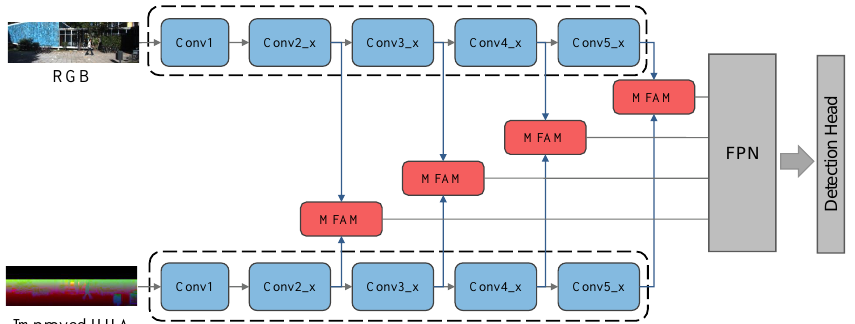
Figure 6. The structure of our pedestrian detection network.